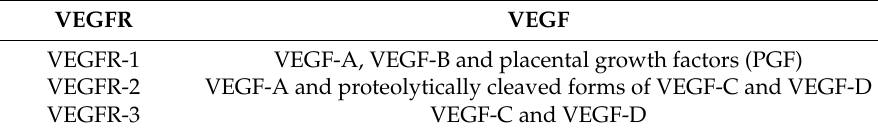
Table 1. Overview of compatible vascular endothelial growth factors (VEGFs) and VEGF receptors (VEGFRs). VEGFR